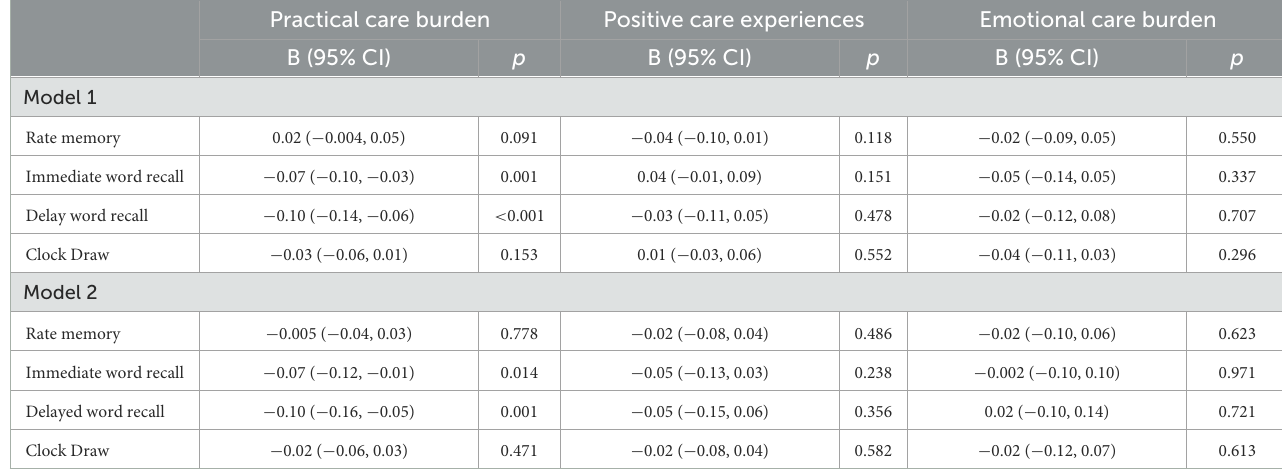
TABLE 5 Association between caregiver experience and care recipient cognitive test performance among care recipients without dementia